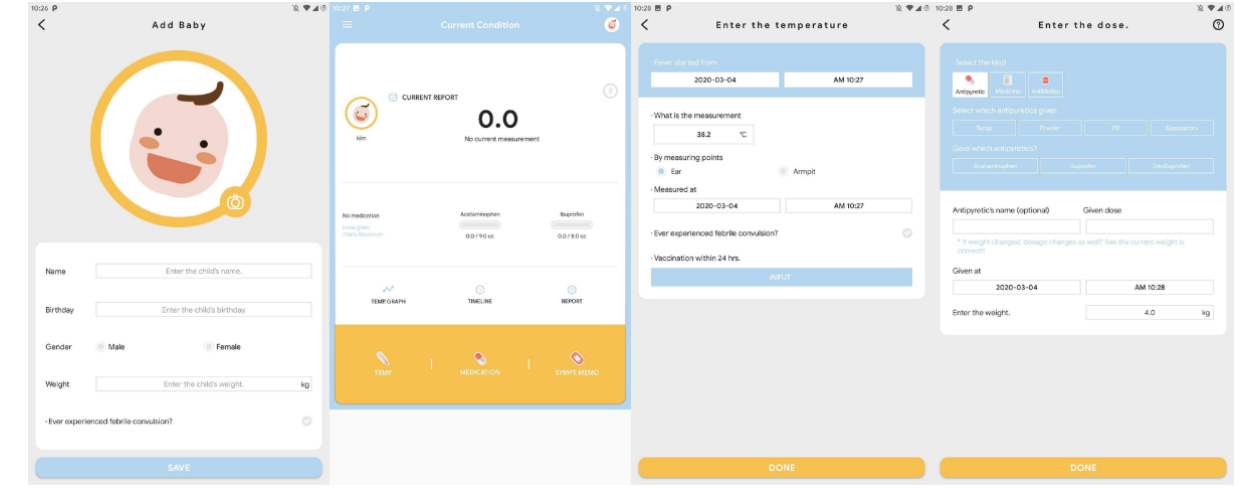
Figure 1. Screenshots of the Fever Coach